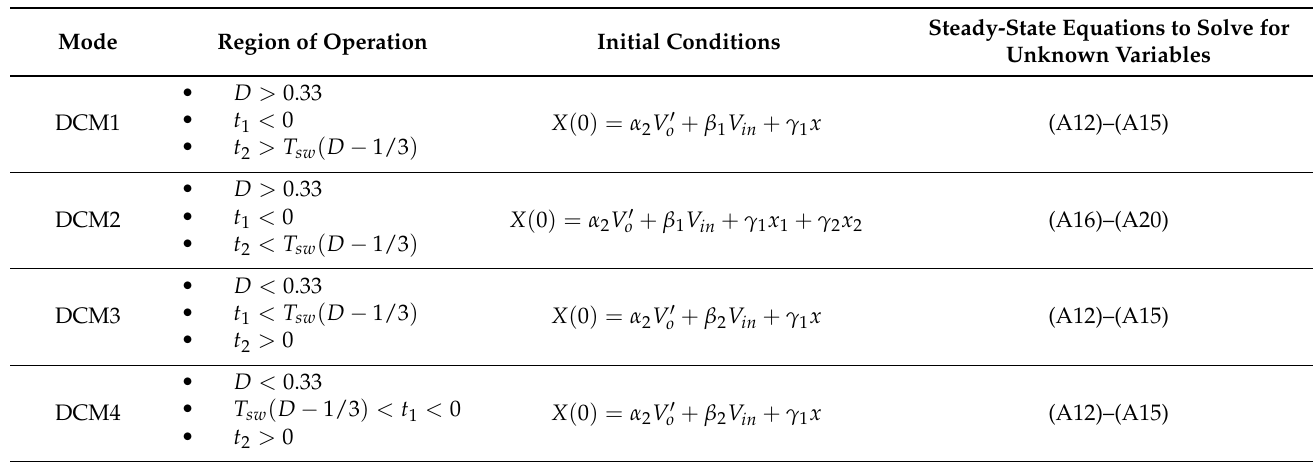
Figure 11. Waveforms for DCM modes. Table 2. DCM mode